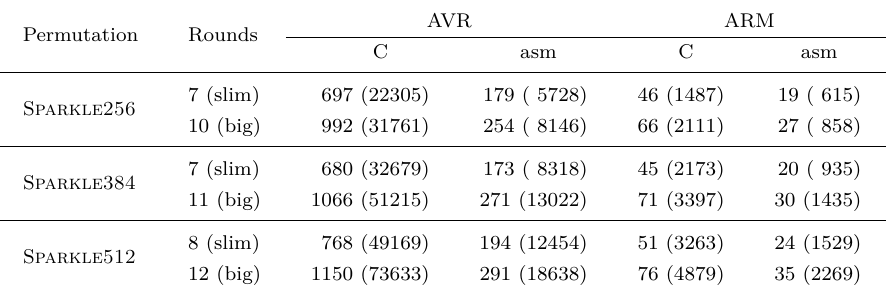
Table 10: Performance of the Sparkle permutations on an 8-bit AVR ATmega128 and a 32-bit ARM Cortex-M3 microcontroller. The results are given in cycles/byte, with the number inside parentheses representing the total cycle count for an execution of the permutation (including function-call